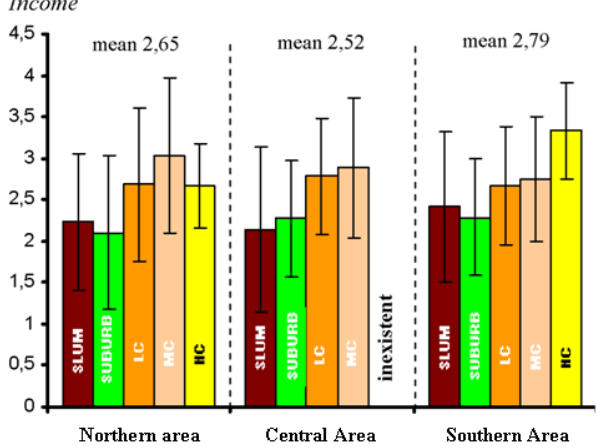
Fig. 6. Location-based mean value correlation of semantic classes and the socioeconomic parameter income and their standard deviations.